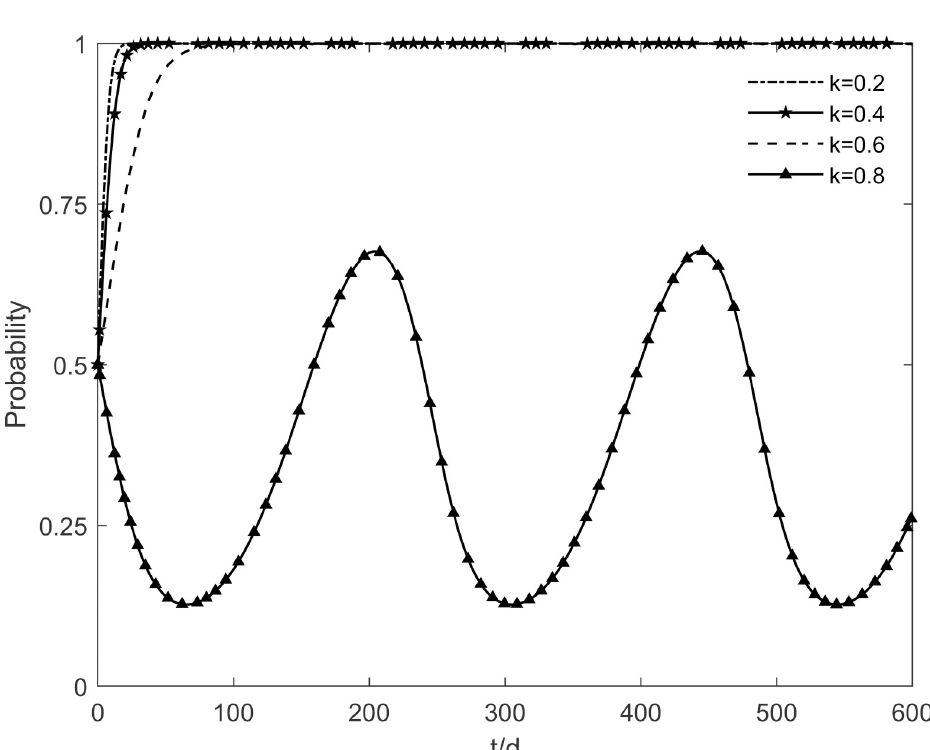
Fig 20. The impact of k on residents’ strategic choices.